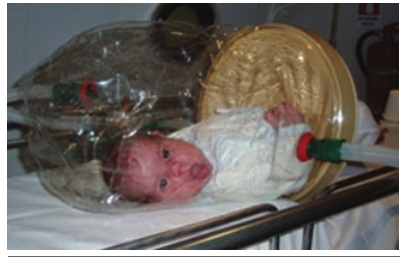
Figure 1. A child introduced from the belly to the head into a classic adult head hel- met.